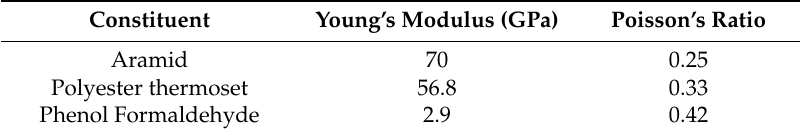
Figure 7. The real RVE ( a ), and the simulation RVE with periodic boundary conditions ( b ). Table 3. Mechanical properties of the constituent materials.